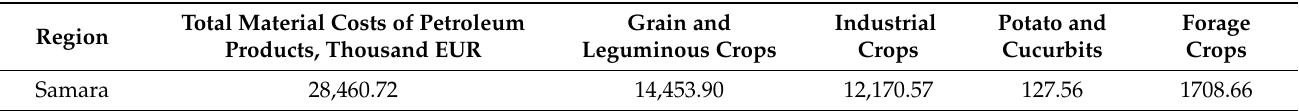
Table 5. Material costs of petroleum products from cultivation of agricultural crops in areas of the Samara region in 2018.